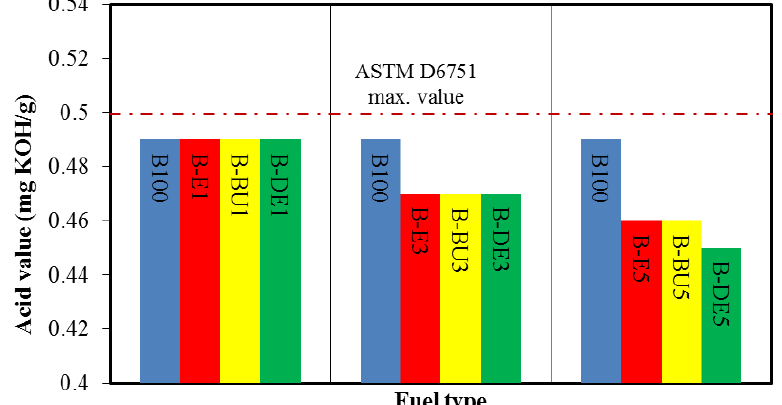
Figure 6. Variation in palm oil methyl ester acid value with increasing blending ratio for different